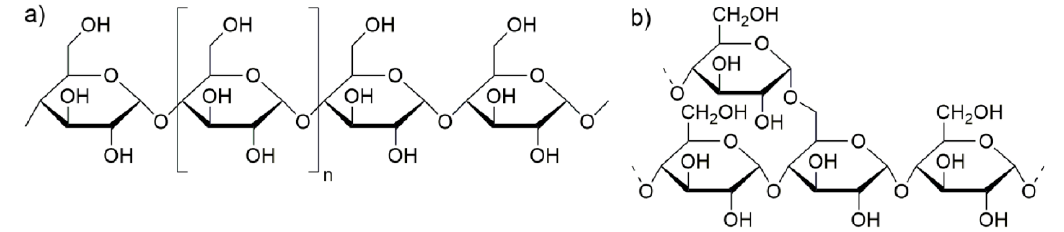
Figure 1. Molecular structure of ( a ) amylose and ( b ) amylopectin.